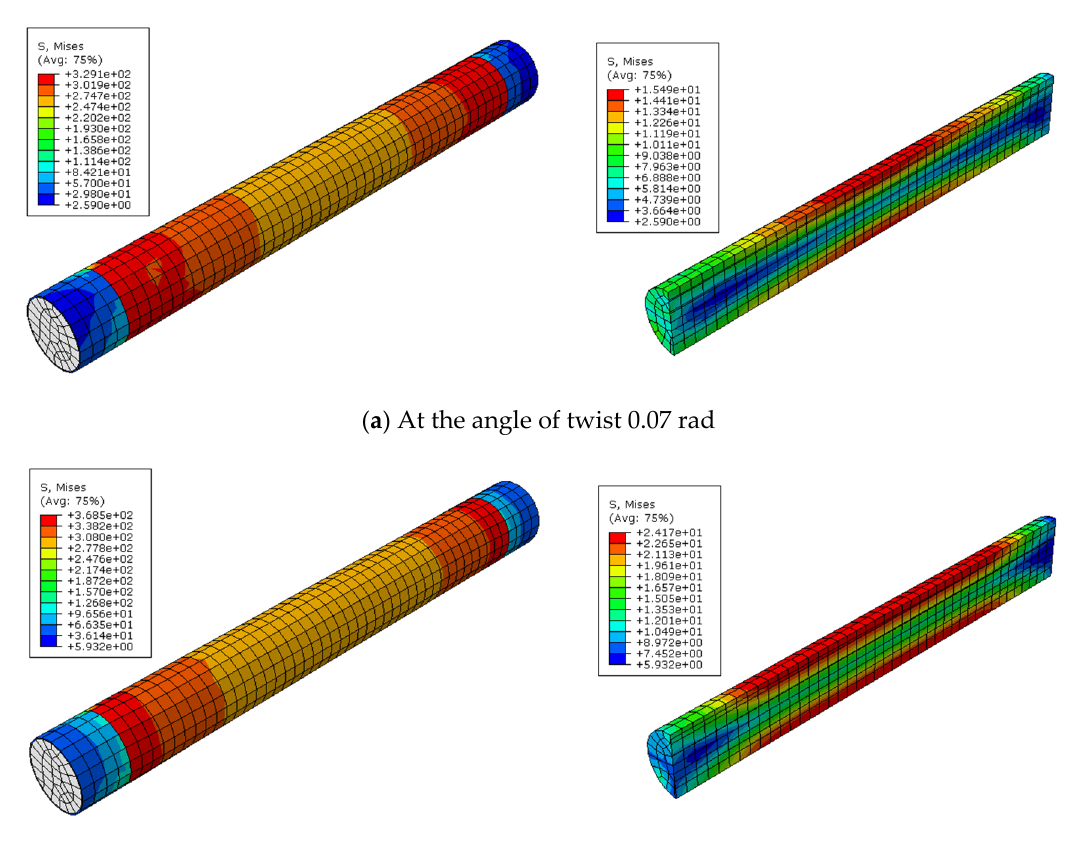
Figure 9. Examples of stress distribution in steel tube and concrete (unit is in MPa).